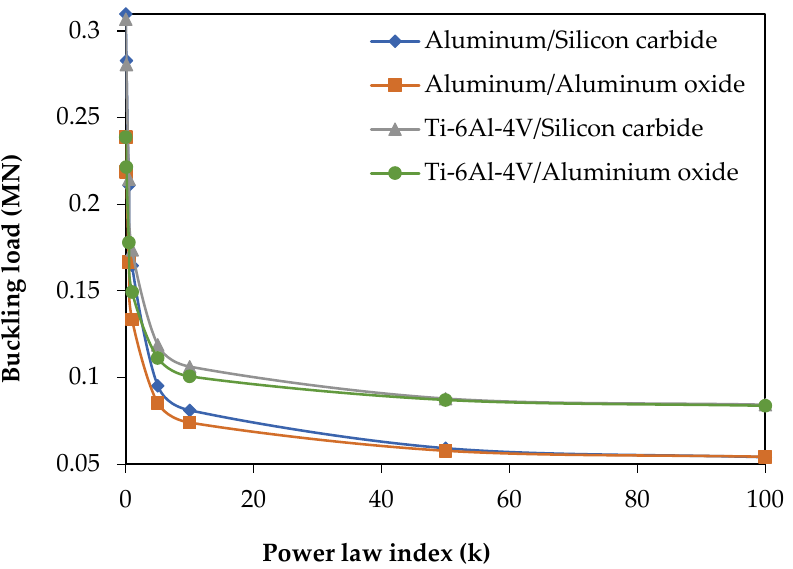
Figure 4. Buckling load (first mode) variation with a power law index for different material combinations for re-entry vehicle nose shell structures.